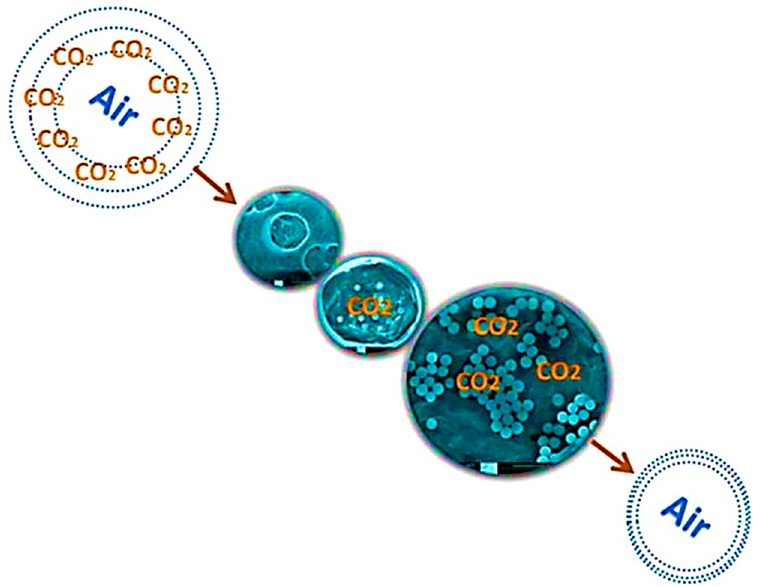
Figure 1. Schematic of CO 2 separation by poly(vinylidene-fluoride-hexafluoropropylene)/amino- silica nanoparticle based nanocomposite membranes [42]. Reproduced with permission from Else- vier.